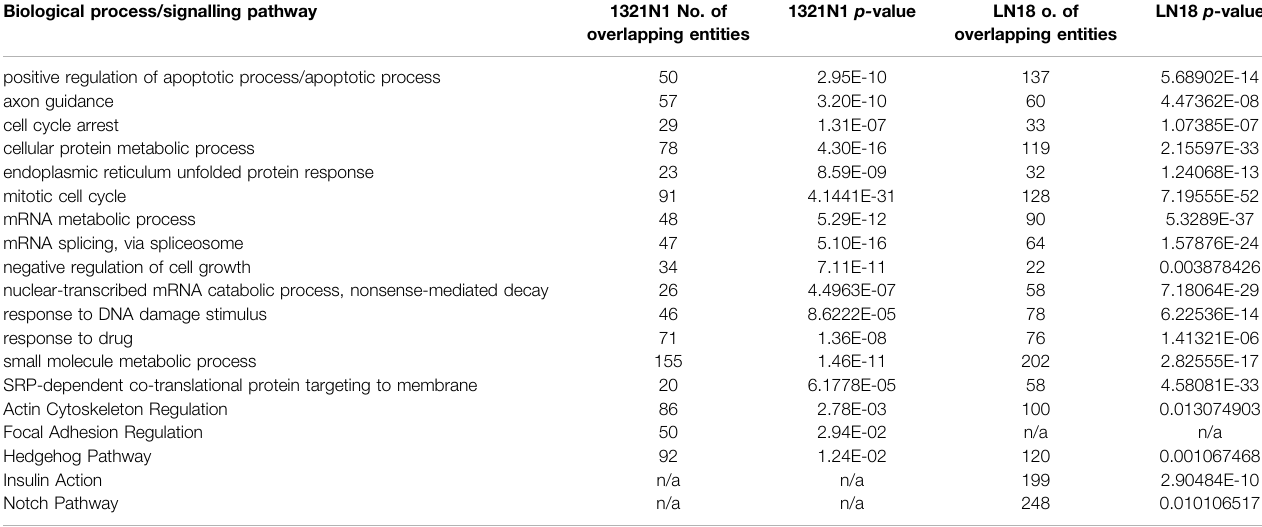
1321N1 p- value overlapping entities